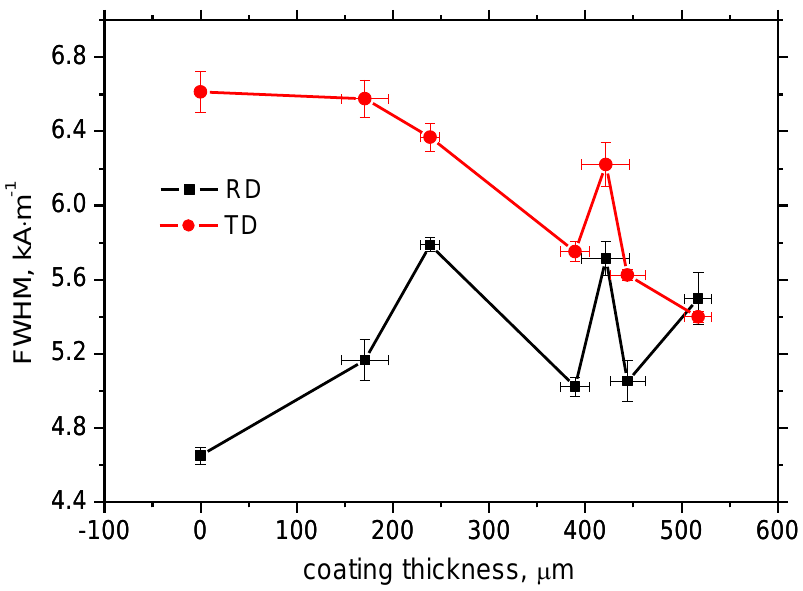
Figure 8. Coating thickness (obtained from the LM observations) versus full width at half maximum ( FWHM ).